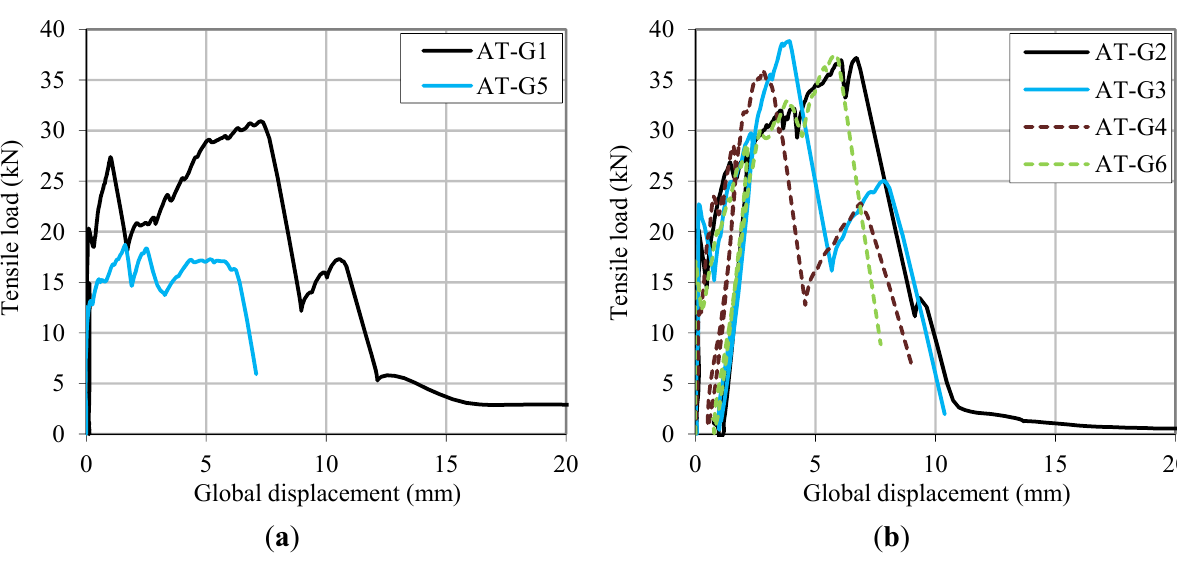
Figure 16. Load-displacement curves. ( a ) Specimens AT-G1/G5 with mesh L200; and ( b ) Specimens AT-G2/G3/G4/G6 with mesh L500.